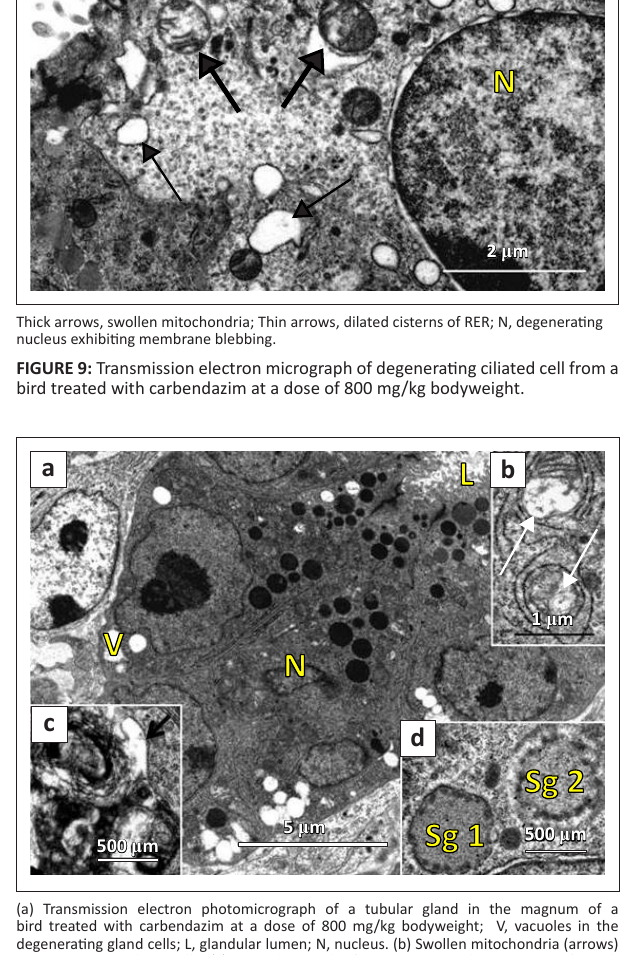
(a) Transmission electron photomicrograph of a tubular gland in the magnum of a bird treated with carbendazim at a dose of 800 mg/kg bodyweight; V, vacuoles in the degenerating gland cells; L, glandular lumen; N, nucleus. (b) Swollen mitochondria (arrows) in degenerating gland cells. (c) Asterisks, myelin figures; Arrow, dilated cistern of rough endoplasmic reticulum (RER). (d) Electron photomicrograph of degenerating secretory granules (Sg 1&2). Note the deposition of electron dense granules in the peripheral zone (Sg1) and discontinuation of a limiting membrane (Sg 2). FIGURE 10: Transmission electron photomicrograph of a tubular gland in the magnum of a bird treated with carbendazim at a dose of 800 mg/kg bodyweight.